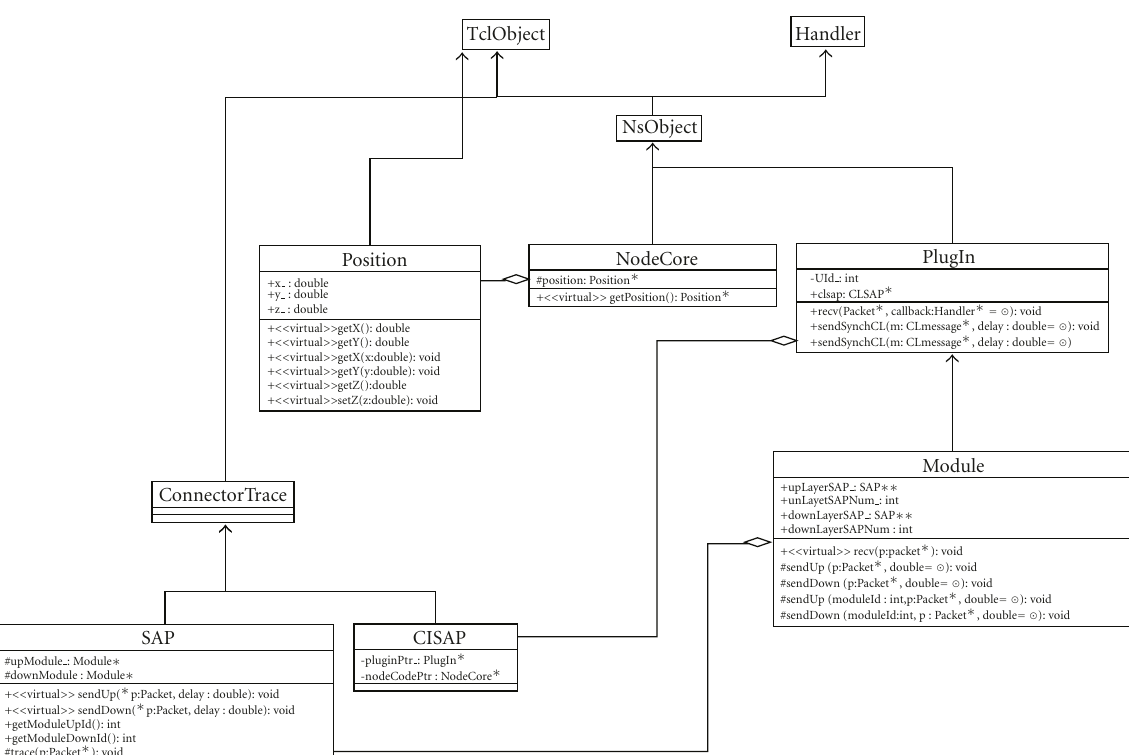
Figure 2: Class diagram for the Miracle